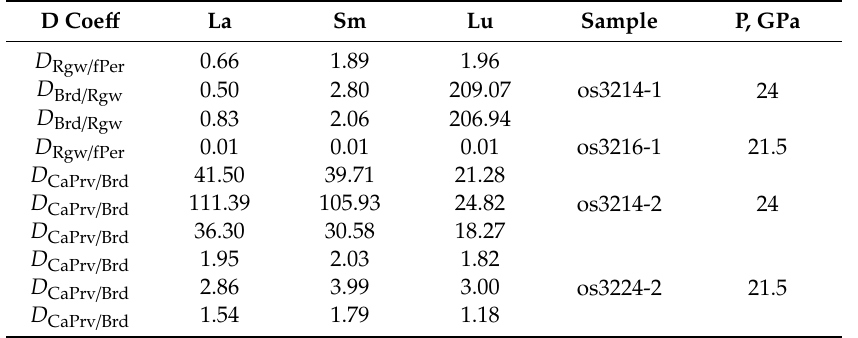
Table 4. Partition coe ffi cients for synthetic phases from runs at 1600 ◦ C with 3REE starting composition. D Coe ff La Lu